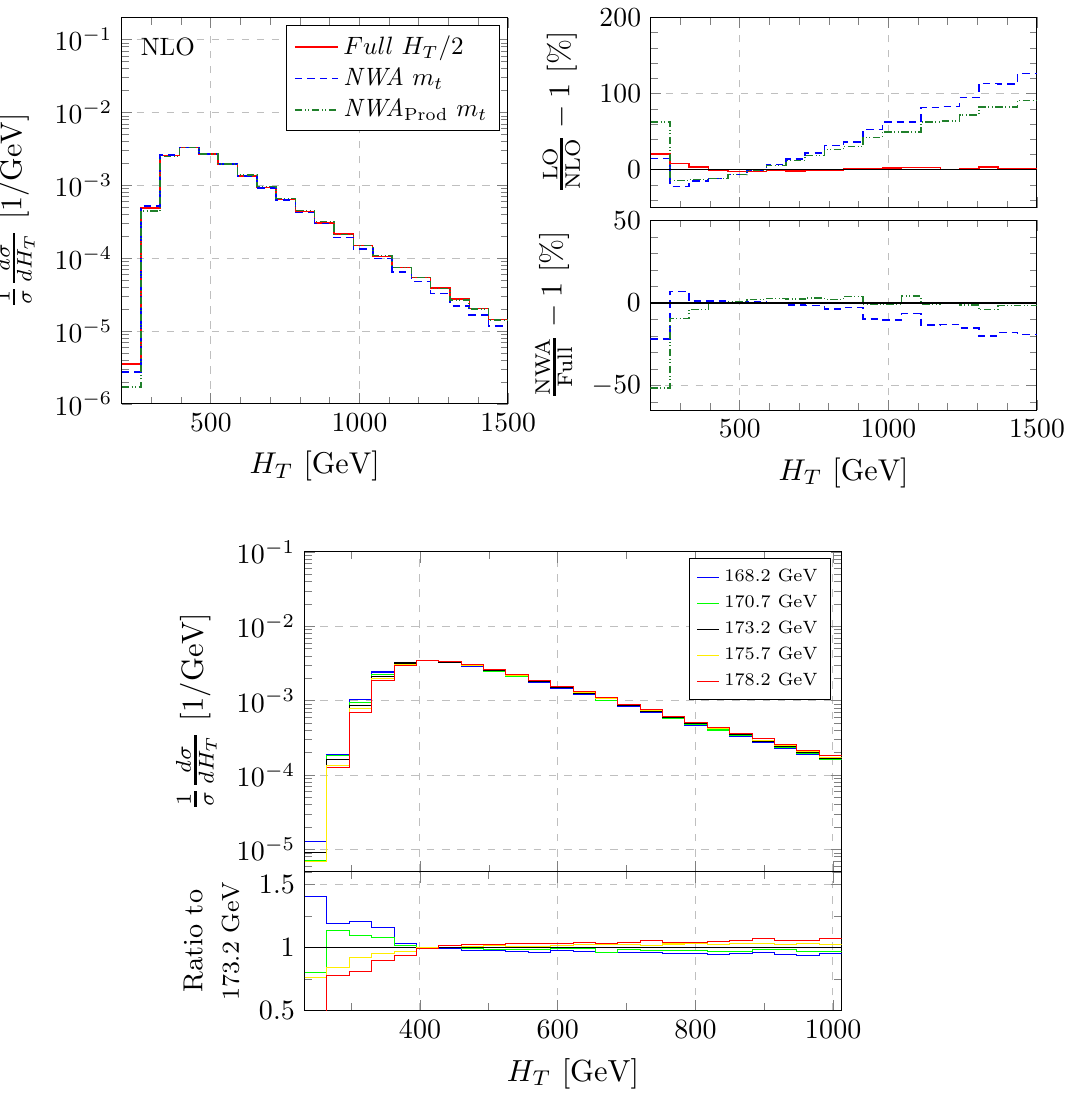
(cid:22) bj + X production + (cid:23) e (cid:22) (cid:0) (cid:22) (cid:23) (cid:22) b